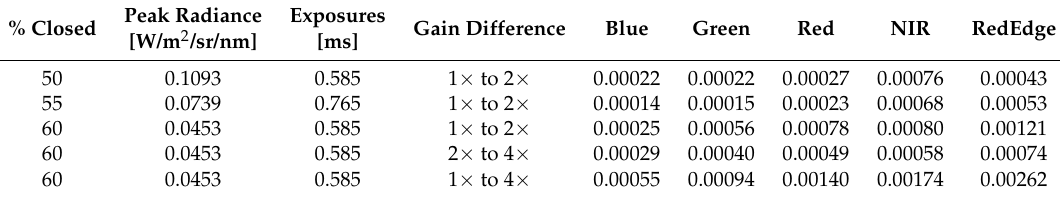
Table 8. RedEdge-3 gain error for various light level, gain and exposure combinations. Digital count imagery was captured using an integrating sphere using a variety of light levels, gains and exposure times. Gain error was calculated by comparing the measured digital counts between images where the gain was the only variable difference.